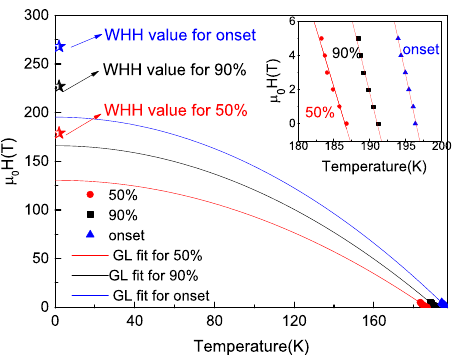
Fig. 4 The superconducting parameters. The Ginzburg Landau fi tting for the H c2 (T) shown with the solid lines. The stars represent the H c2 (0) values calculated via WHH model. The inset of Fig. 4 is the critical fi eld Hc2(T) as a function of T c with the T c values determined by the criteria of the T c onset , 90 and 50% of normal state